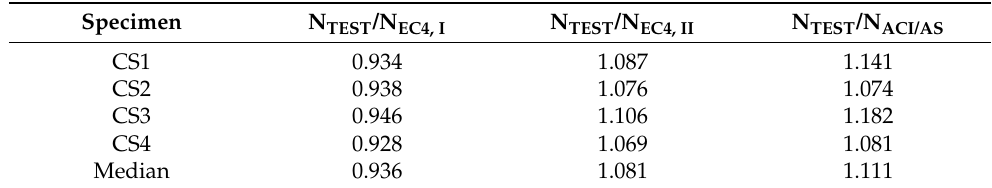
Table 7. Comparison between the buckling force obtained by experiments and calculated by de- sign